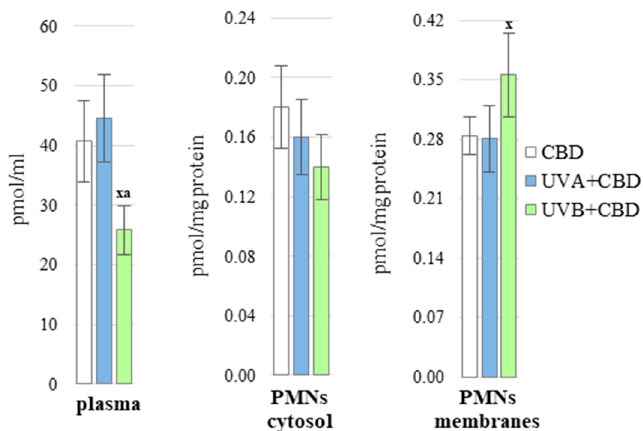
Figure 1. The level of CBD in blood plasma and PMNs (cytosol and membranes fraction) of nude rats in the following groups: treated with CBD (every 12 h) for 4 weeks; irradiated with UVA (every 48 h) and treated with CBD (every 12 h) for 4 weeks. irradiated with UVB (every 48 h) and treated with CBD (every 12 h) for 4 weeks. The mean values for six rats in each group ± SD are shown: x—differences vs. CBD group, p < 0.05; a—differences vs. UVA + CBD treated group. CBD partially prevented redox imbalances in the blood of rats exposed to UV